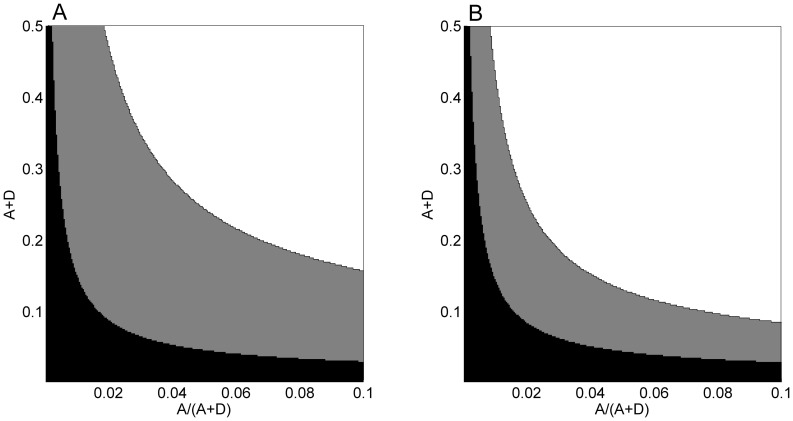
Model results: alternating between selective and non-selective feeding seems to be a good strategy for a wide range of conditions.The horizontal axis is taken as the overall edible algae frequency in the fish's habitat (), and the vertical axis is taken as the relative frequency of a highly nutritious alga amongst all algae verities . White areas define parameter ranges under which a switch from selective feeding to bulk feeding is favorable even when diminishing benefit is not assumed (); gray areas are the additional parameter ranges under which a switch between strategies is favorable when adding a diminishing benefit function to the nutritional value of the rare, preferable alga, as defined in the main text; black areas represent conditions under which selective feeding is not an optimal strategy even at the beginning of the day. Panel A is plotted under the assumption of a constant energy content (V) during the day, while panel B is plotted under the assumption of an increasing energy content function. The parameters used to produce the figures are: .